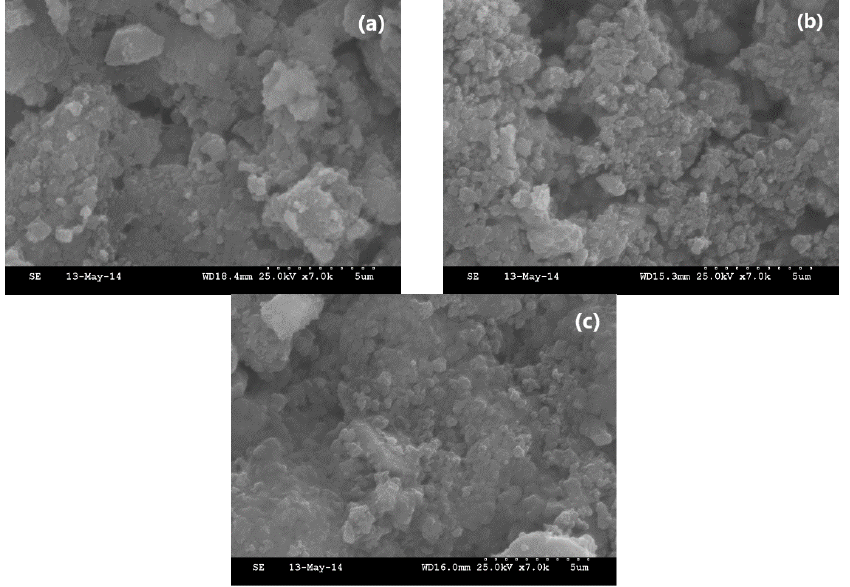
Figure 7. Micromorphology of the concrete surface treated by different materials: ( a ) without treatment; ( b ) silane emulsion; ( c ) SiO 2 sol/silane emulsion (S3).